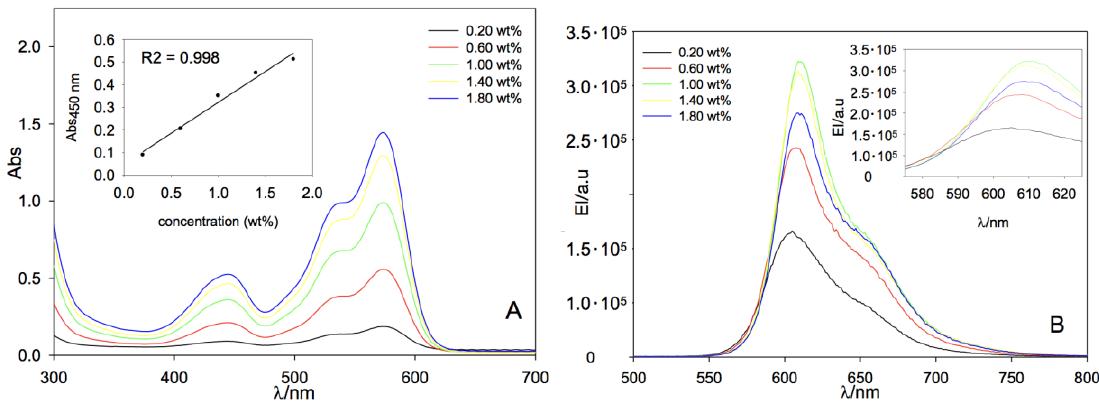
Figure 6. ( A ) UV–VIS absorption. In the inset, the absorbance maximum at 450 nm as a function of LR concentration and ( B ) fluorescence emission spectra PMMA films at increasing dye concentration. λ exc = 450 nm and film thickness of 23 ± 6 µ m.